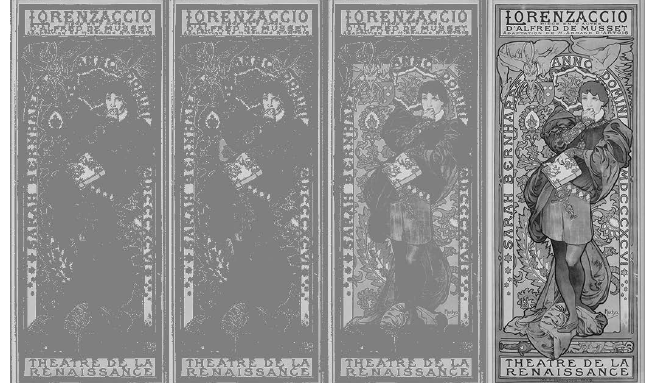
Figure 25: Four stages in the unfolding of area and colour in a Mucha painting in section 5 of ) ertur